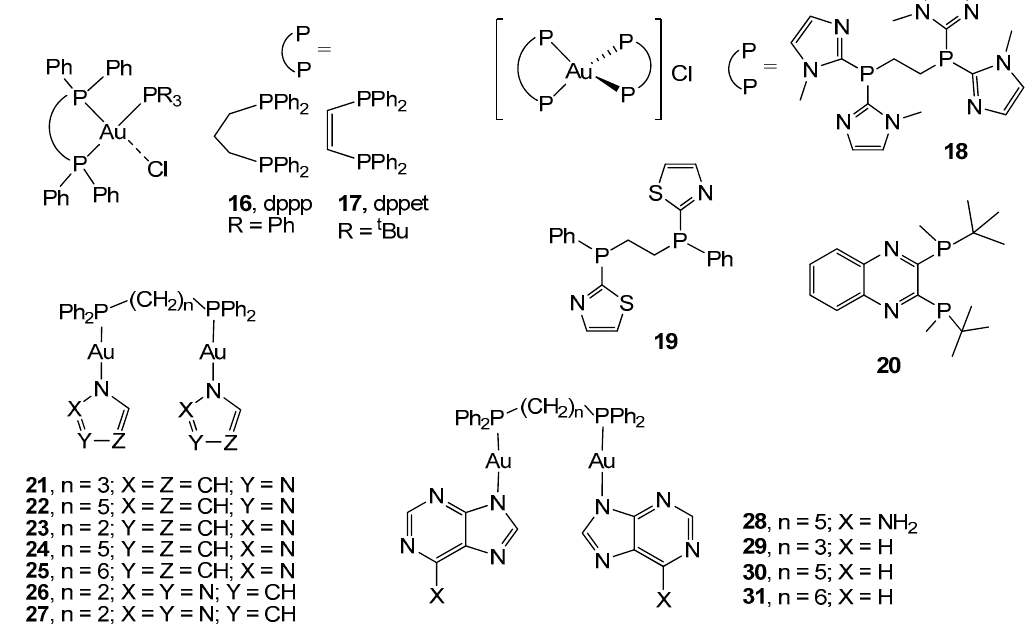
Figure 2. Gold(I) derivatives with bidentate phosphanes.